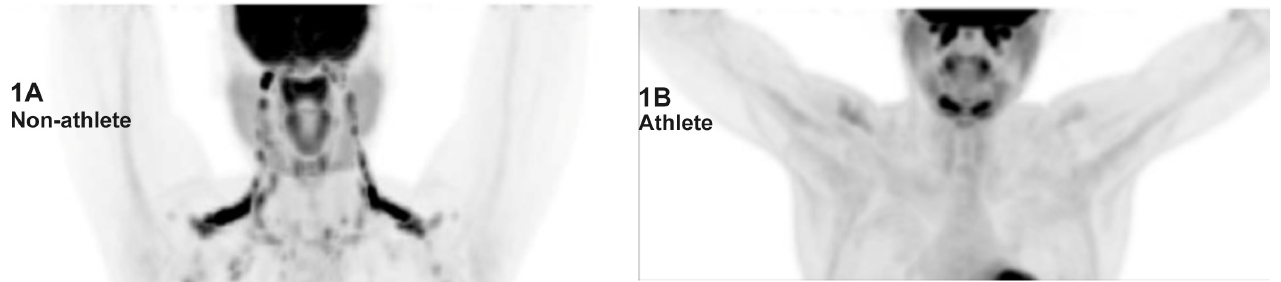
Fig 1. Brown Fat Activity Differences between Athletes and Non-Athletes. (1A) Maximum Intensity Projection of an 18F-FDG PET-CT scan performed in a non-athlete shows multiple and bilateral foci of increased glucose uptake along the laterocervical, supraclavicular, axillary regions, corresponding to metabolically active BAT in these regions. ( 1B) Maximum Intensity Projection of an 18F-FDG whole body PET-CT scan performed in an athlete. Physiological glucose uptake is seen in the brain, salivary glands and myocardium. No active BAT is seen in this patient.